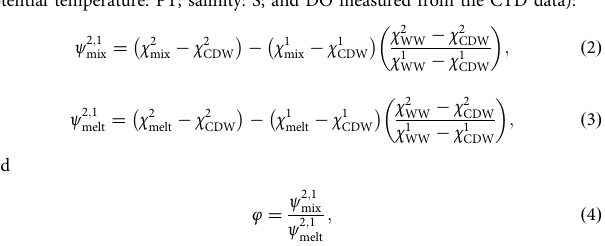
Supplementary Fig. 2. Based on the estimated sea-ice motion, a cyclonic gyre occurred in front of PIIS in late 2012 (late 2019), and a double-gyre was observed in front of PIIS in late